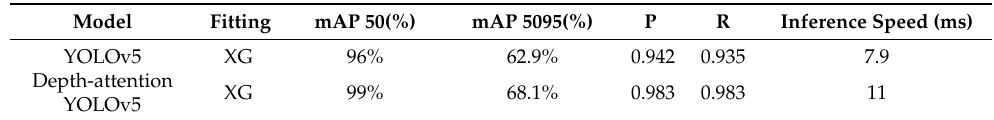
Table 3. Comparison of the YOLOv5 and depth-attention YOLOv5.